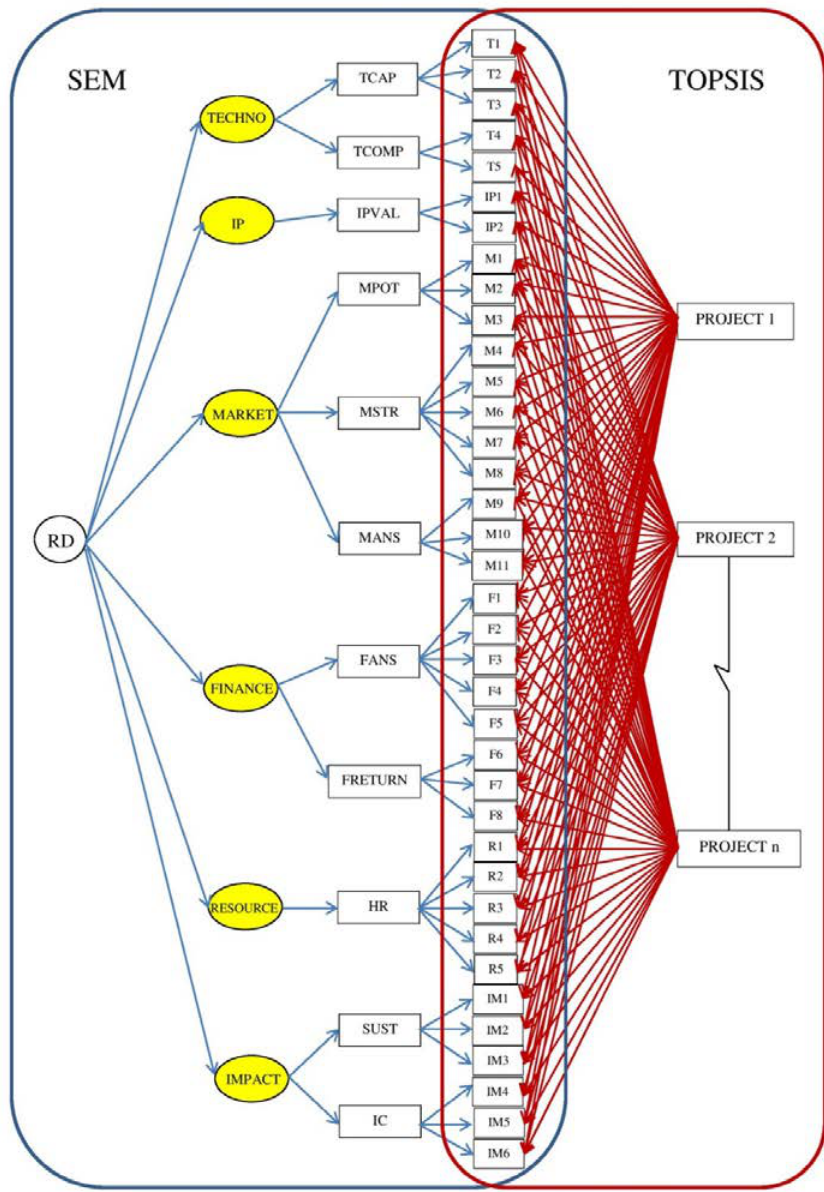
Fig. 3. SEM-TOPSIS